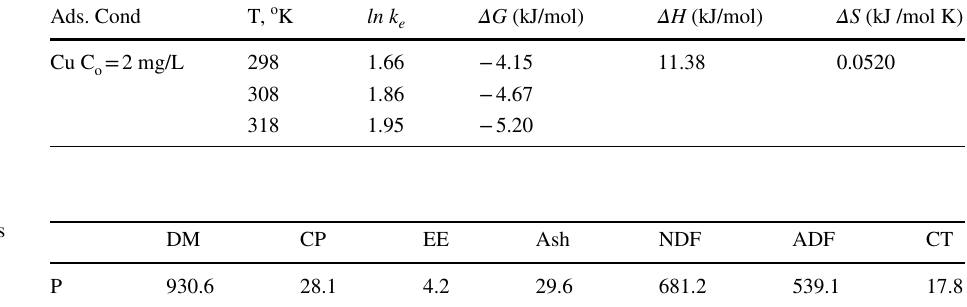
Table 3 Thermodynamic data for P-Cu adsorption system